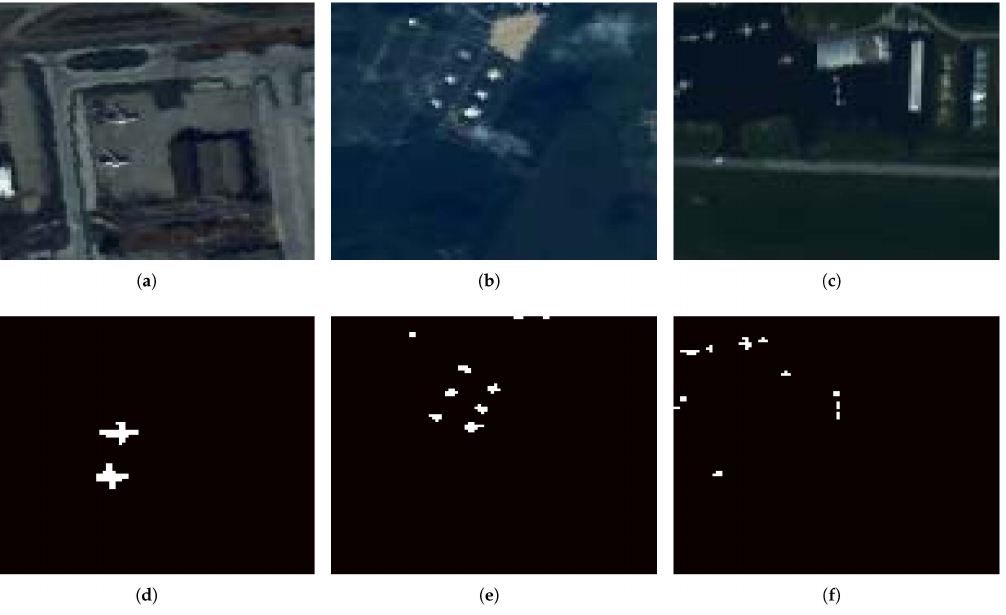
Figure 4. Image scene descriptions. ( a ) False color image of the abu-airport-2 dataset. ( b ) False color image of the abu-urban-1 dataset. ( c ) False color image of the abu-urban-3 dataset. ( d ) The ground truth map of the abu-airport-2 dataset ( e ) The ground truth map of the abu-urban-1 dataset. ( f ) The ground truth map of the abu-urban-3 dataset.